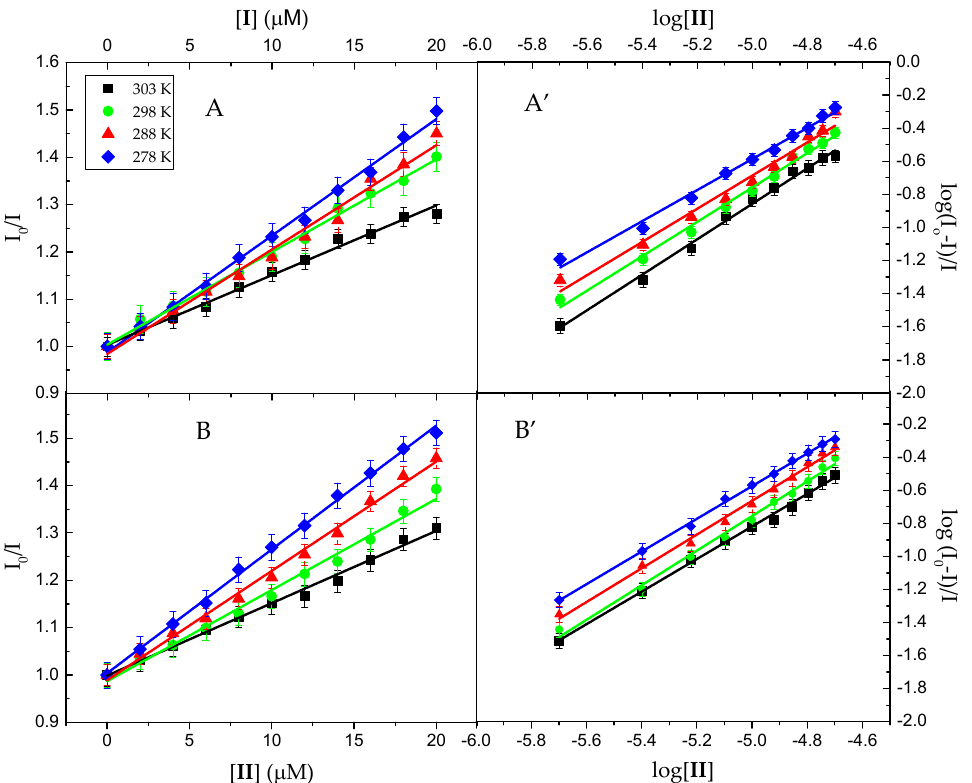
Figure 8. Stern-Volmer ( A , B ) and log(I 0 -I)/I versus log(molecule) ( A’ , B’ ) plots for quenching of BSA by I ( A , A’ ) and II ( B , B’ ) at different temperatures.